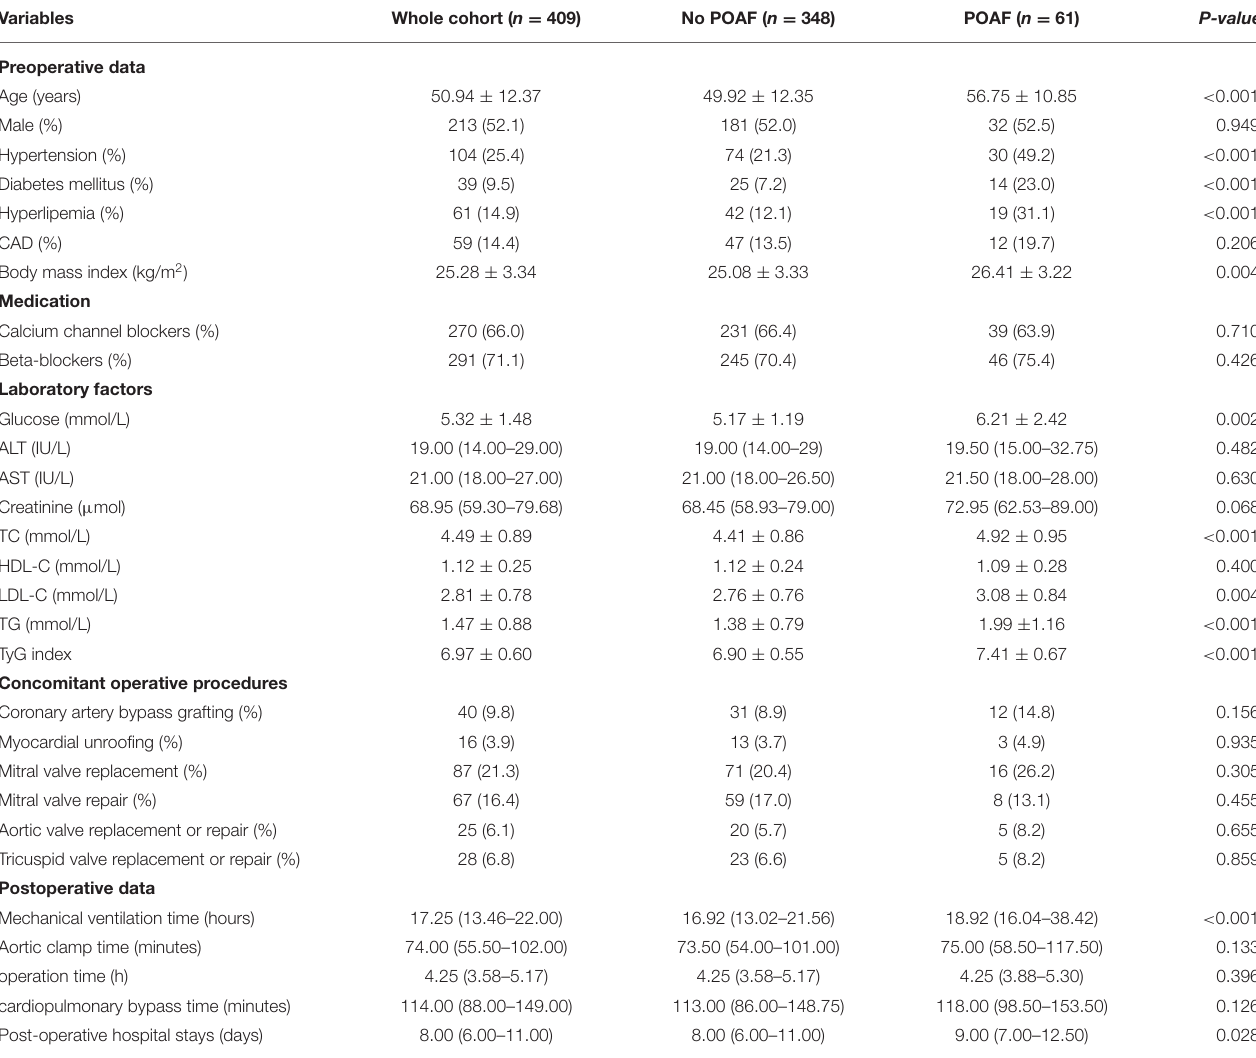
TABLE 1 | Perioperative clinical variables of